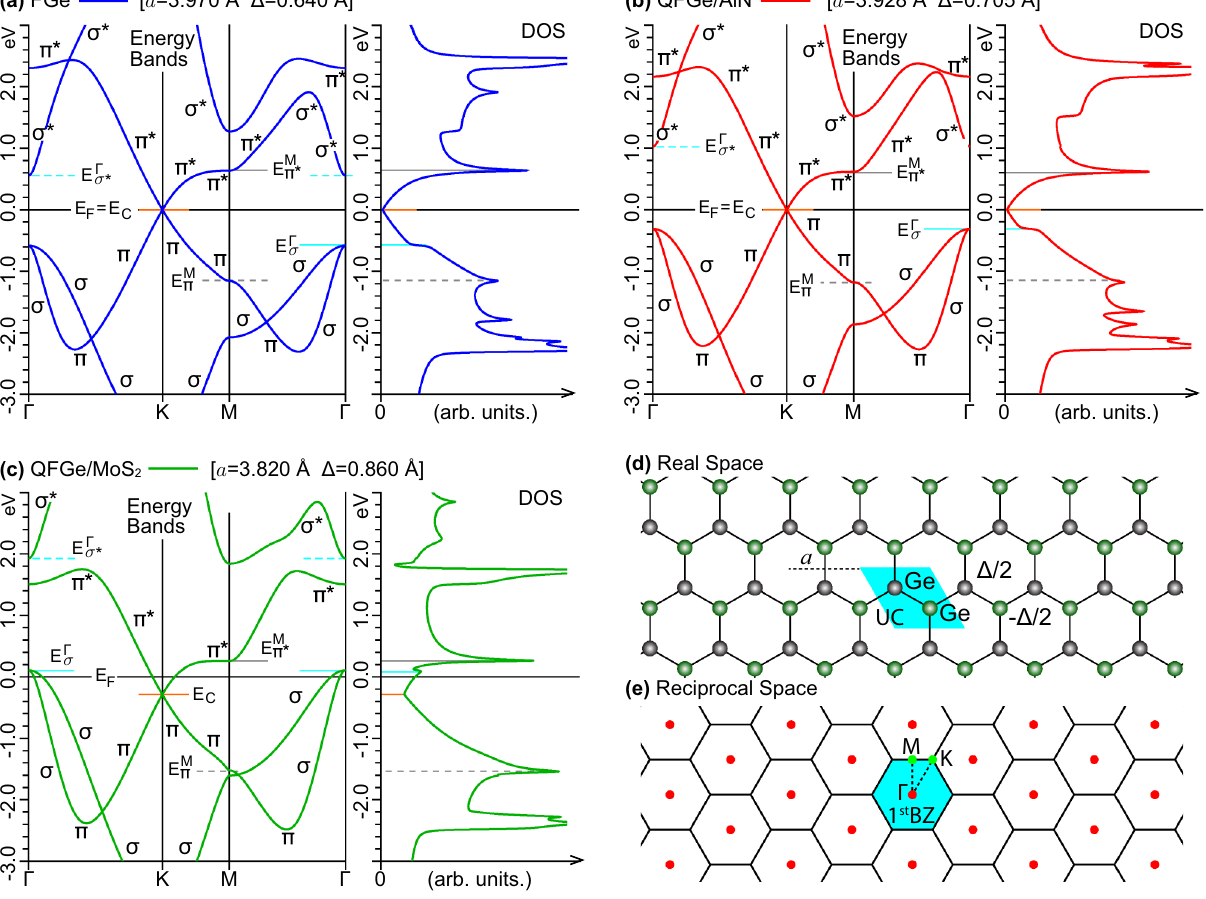
Figure 1. Band structure and DOS profiles of ( a ) FGe, ( b ) QFGe on AlN , and ( c ) QFGe on MoS 2 , within an 0 ). The energy dispersions are associated to occupied energy window of 6 eV centered at the Fermi level ( E F = or empty states with dominant σ ( σ ∗ ) and π ( π ∗ ) characters. The DOS curves are shown convolved with a Lorentzian lineshape having a phenomenological broadening of 0.01 eV. The other energy labels, and related horizontal lines, denote the positions of the Dirac cone ( E C ), the highest (degenerate) σ -like states at Ŵ ( E Ŵ σ ), the lowest σ ∗ -like states at Ŵ ( E Ŵ σ ), the highest π -like VHS at M ( E π M ), and the lowest π ∗ -like VHS at M ( E π ∗ M ). ( d ) ∗ Real and ( e ) reciprocal space information, i.e., unit cell (UC), crystal basis, lattice constant a , buckling distance (cid:31) , 1 st BZ and irreducible 1 st BZ, delimited by the Ŵ KM Ŵ path, being also the horizontal axis in the left panels of ( a )–( c